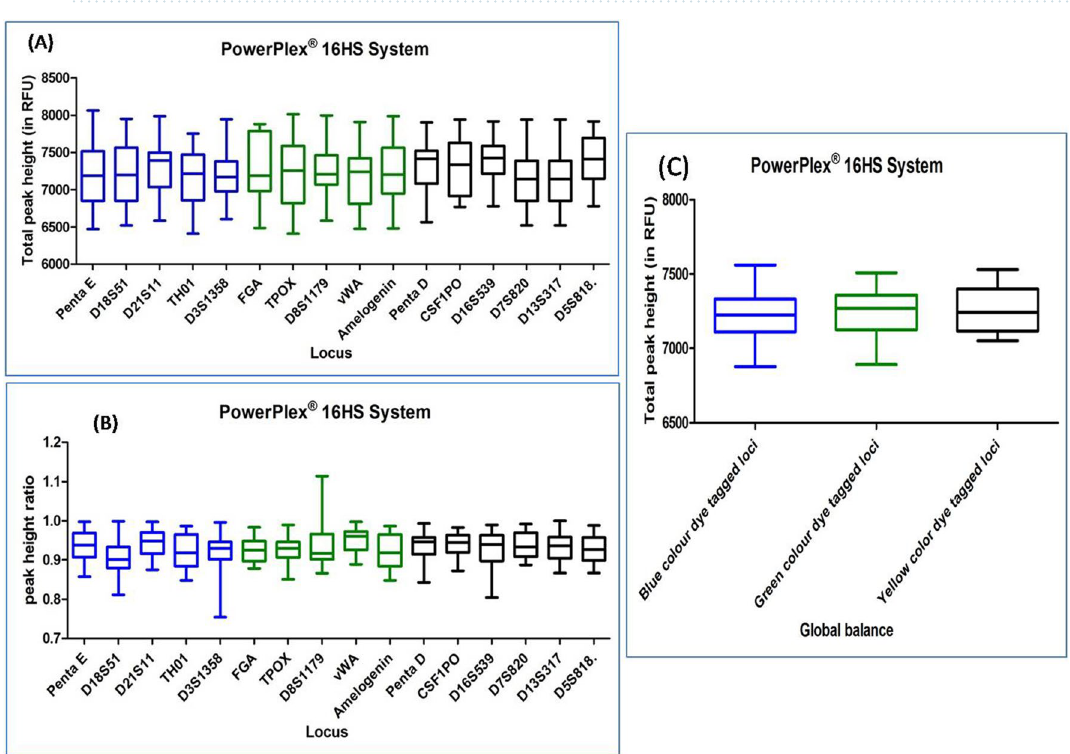
Figure 4. Quality assessment of DNA profile by Dunn’s multiple comparison test for the POWERPLEX 16HS SYSTEM ( A ) Total peak height ( B ) Peak height ratio ( C ) Global